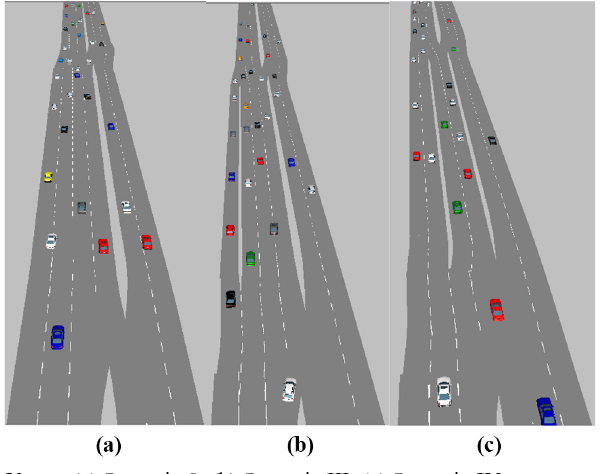
Figure 15 Traf fi c fl ow statuses of different scenarios in the weaving area at 1,800s